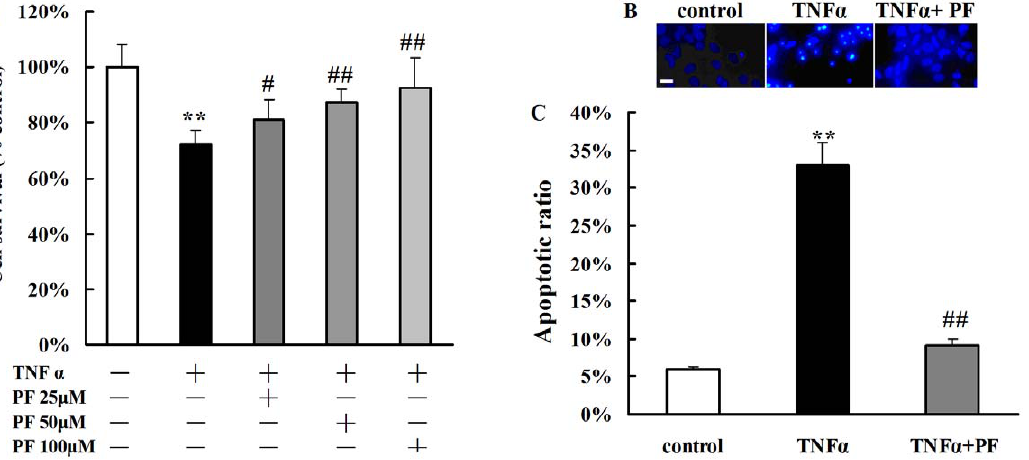
Figure 8. PF treatment protects TNF a -induced cytotoxicity in hippocampal neurons as assessed by MTT(A) and staining with Hoechst33342 (B and C). A and C. TNF a stimulation increased cell apoptosis and cell death in hippocampal neurons. PF inhibited the apoptotic ratio of neurons and promoted cell survival. B. Fluorescence photomicrographs of neurons with Hoechst 33242 staining. Bar=50 m m. ** P , 0.01 vs . control group, # P , 0.05, ## P , 0.01 vs . TNF a group. Data are means 6 S.E.M. n=4.